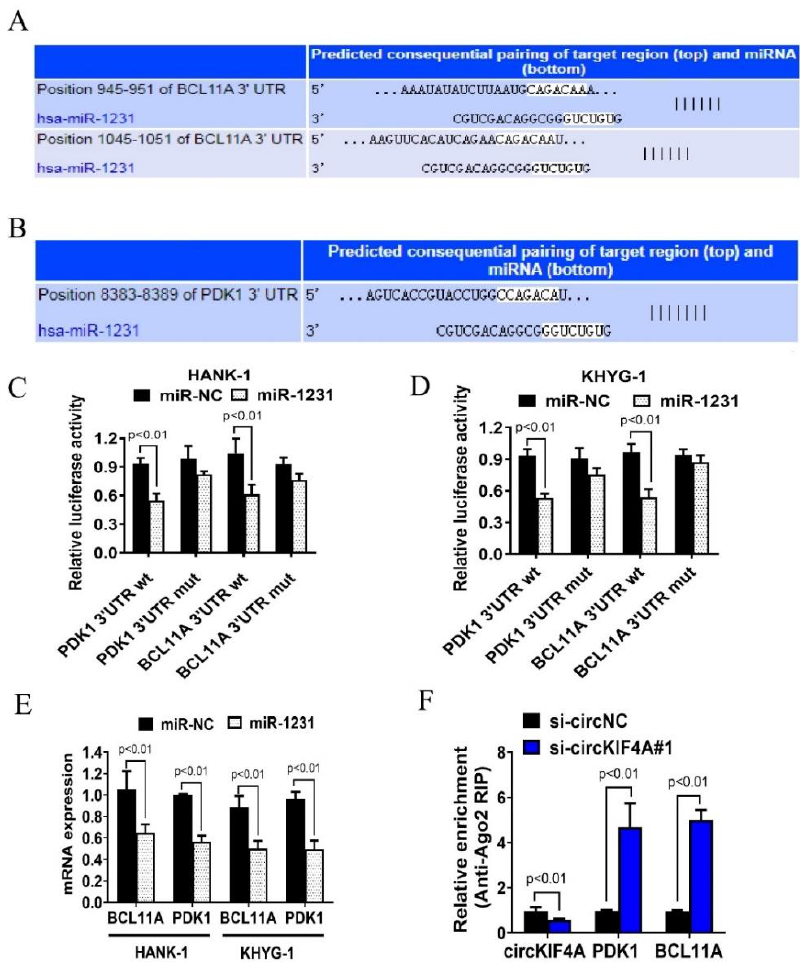
Figure 5. CircKIF4A influences NKTL via the circKIF4A-miR-1231-PDK1/BCL11A axis. ( A , B ) Pre- dicted miR-1231 binding sites in the 3’ UTRs of BCL11A and PDK1. ( C , D ) Cells were transfected and subjected to the luciferase assay. ( E ) The expression of BCL11A and PDK1 was suppressed after transfecting HANK-1 and KHYG-1 cells with miR-1231. ( F ) Cells were transfected and subjected to Ago2-based RIP.